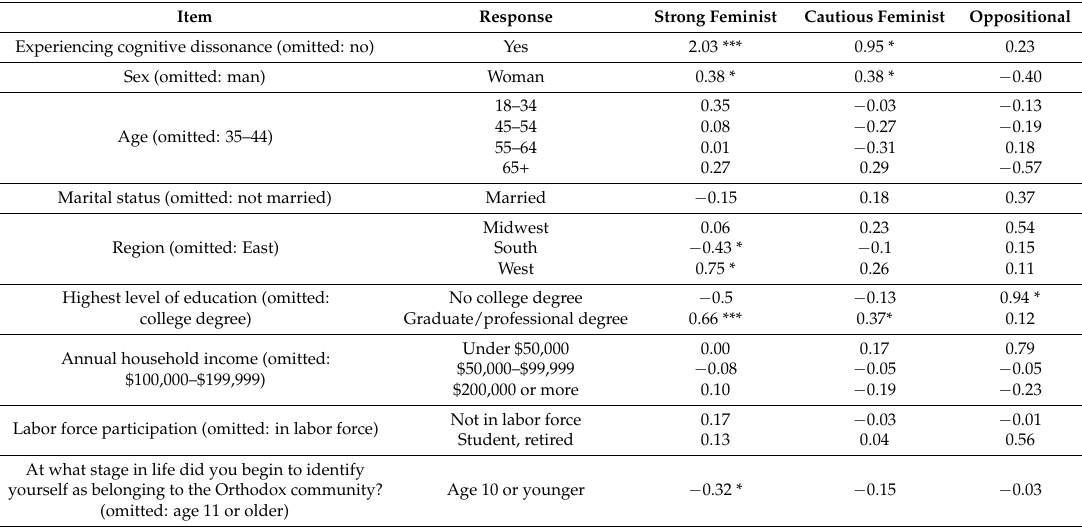
Table 6. Multinomial logistic regression of Orthodox feminist stance on experiencing cognitive dissonance and sociodemographic characteristics